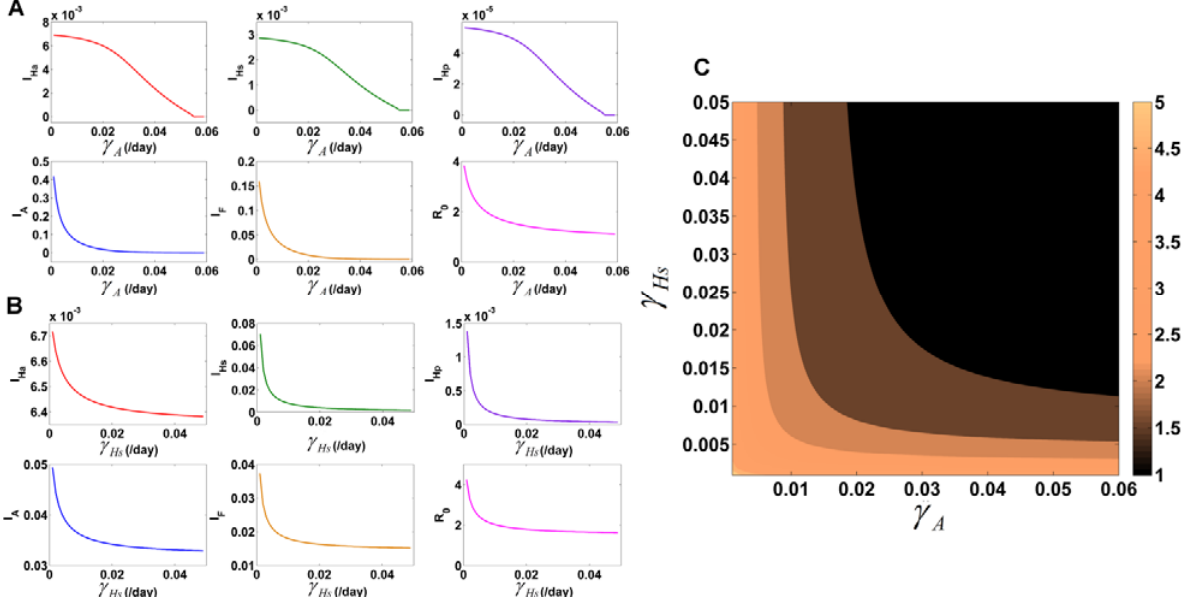
Figure 6. Parameter variations in γ A and γ Hs —( A ) Effect of γ A on equilibrium infection dynamics and R 0 ; ( B ) Effect of γ H on equilibrium infection dynamics and R 0 ; ( C ) Effect of simultaneous variations γ A and γ Hs on R 0